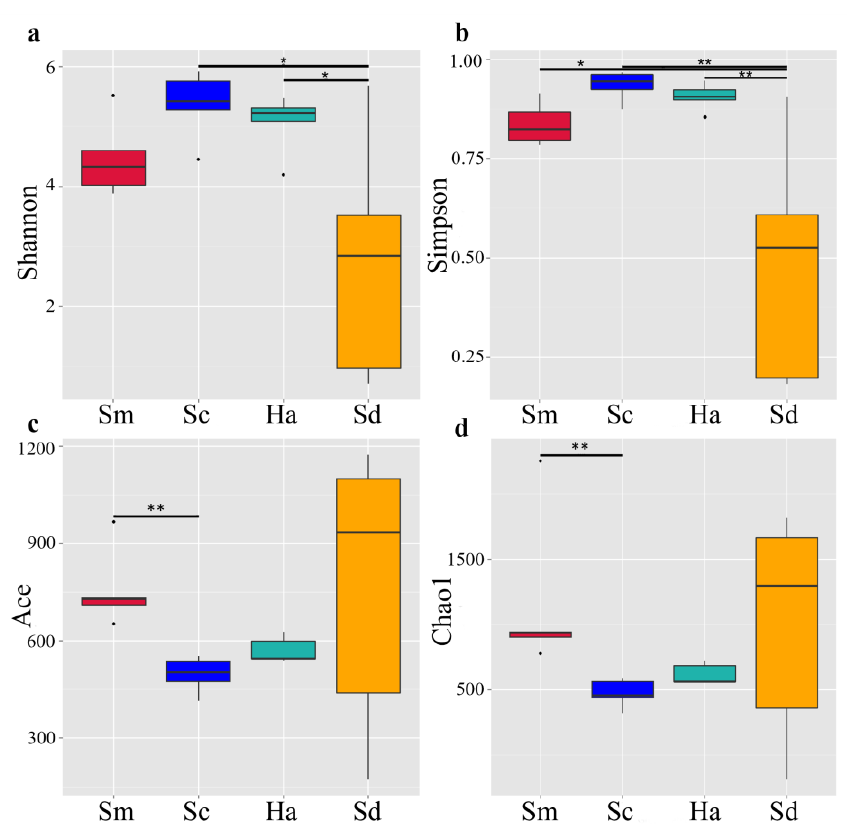
Figure 3. The α -diversity of eukaryotic organism communities in the foregut of S. monotuberculatus (Sm), S. chloronotus (Sc), H. atra (Ha) and the surrounding sediments (Sd): ( a ) Shannon index; ( b ) Simpson index; ( c ) ACE estimator; ( d ) Chao1 estimator. The differences between groups are represented by the differences in the α -diversity index, * p < 0.05; ** p < 0.01.